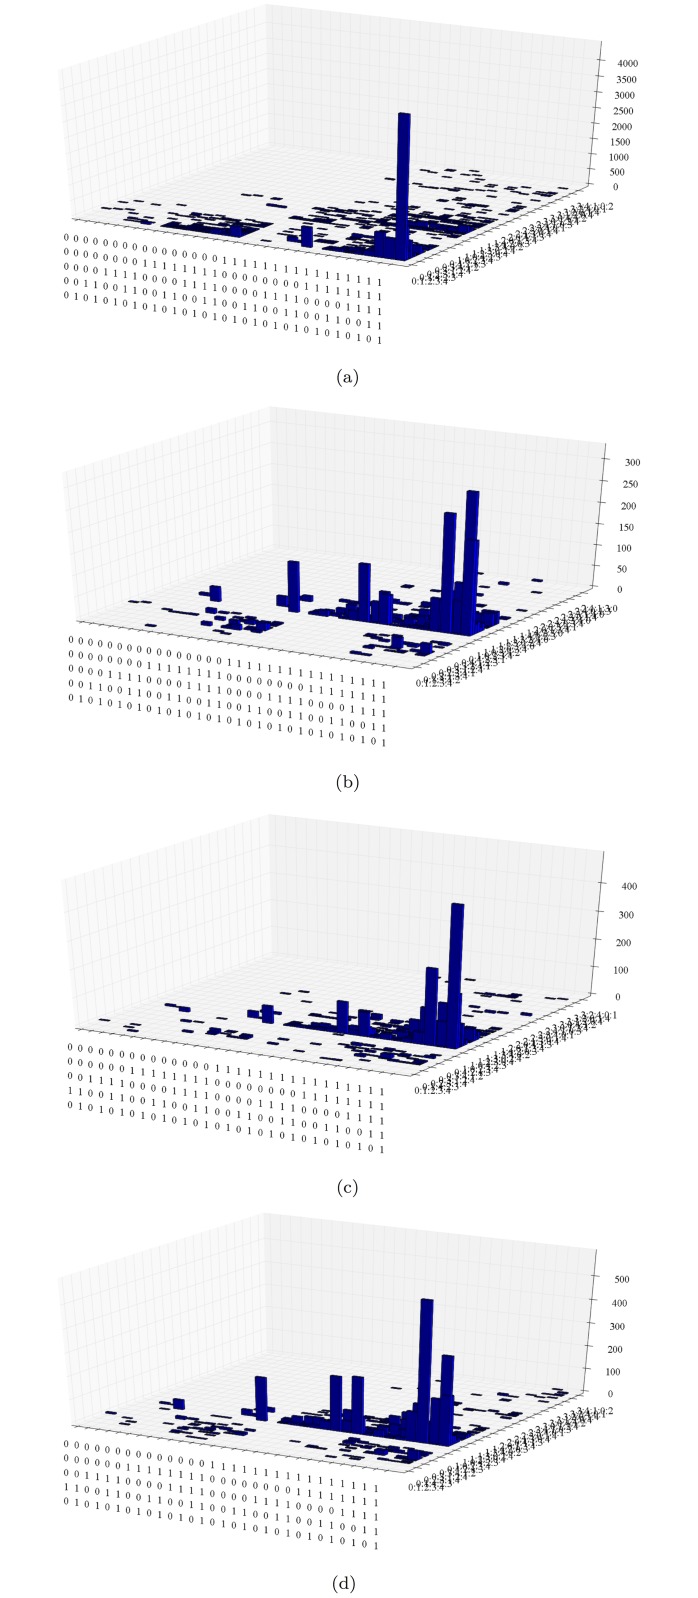
Accumulated number of visits (height of bars) in S
5 of (a) SA Rich, (b) SA Poor, (c) MOZ Rich, and (d) MOZ Poor household orbits.